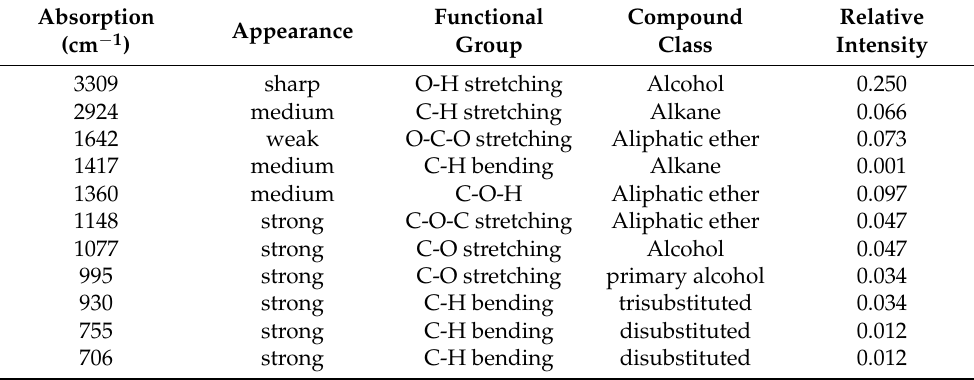
Figure 8. The FT-IR chart of A. pullulans AKW pullulan with a frequency range from 4000 to 350 cm − 1 . Table 5. The FT-IR spectroscopic data of A. pullulans AKW pullulan.